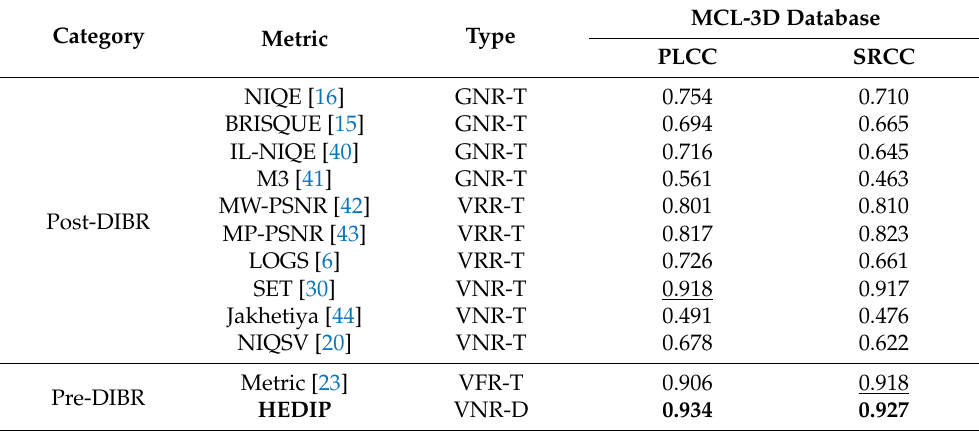
Table 3. Performances of view synthesis quality metrics on the MCL-3D and IST database. The best result is highlighted in boldface, and the second best result is